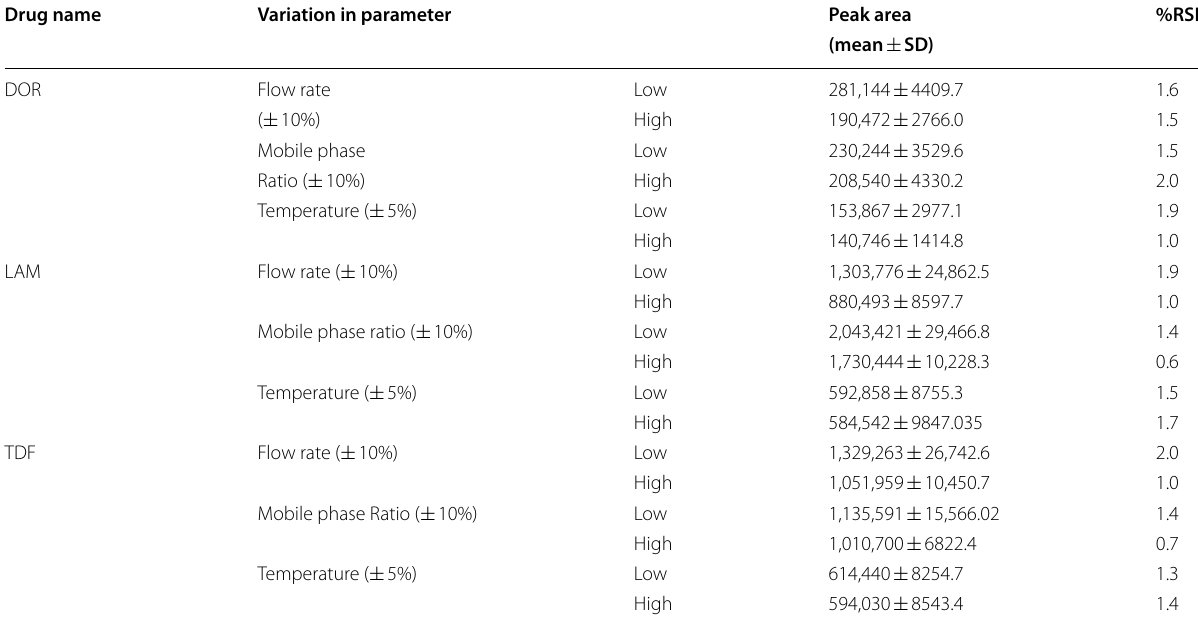
Table 6 Robustness results of DOR, LAM and